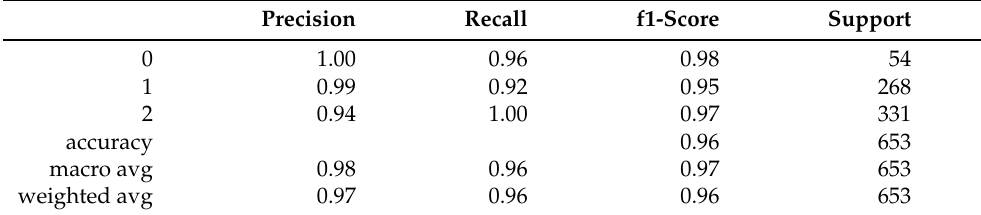
Table 14. KNN metrics on San Lorenzo test case.